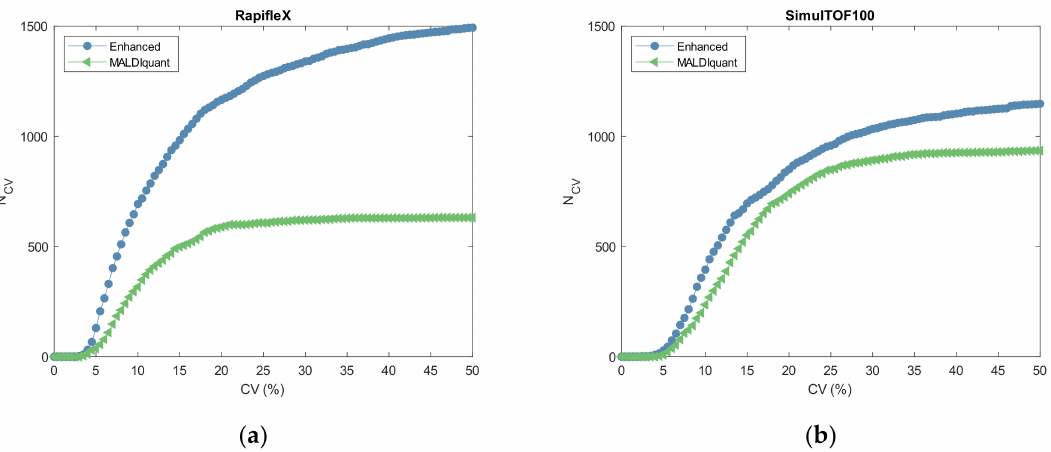
Figure 7. Comparison of reproducibility of our approach to a published method, MALDIquant. Cumulative CV distribution, N CV , for the same Deep MALDI spectra analyzed with the presented methods using enhanced feature values (blue, circles) and with MALDIquant processing (green, triangles) for: ( a ) RapifleX and ( b ) SimulTOF100 acquisitions. Only CVs up to 50% are shown for clarity.